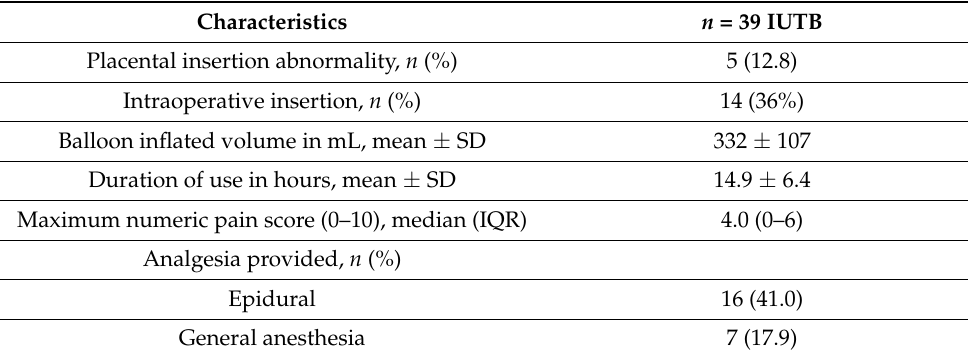
Table 4. Detailed characteristics of all patients who benefited from IUTB. Success was defined as no other hemostatic interventions